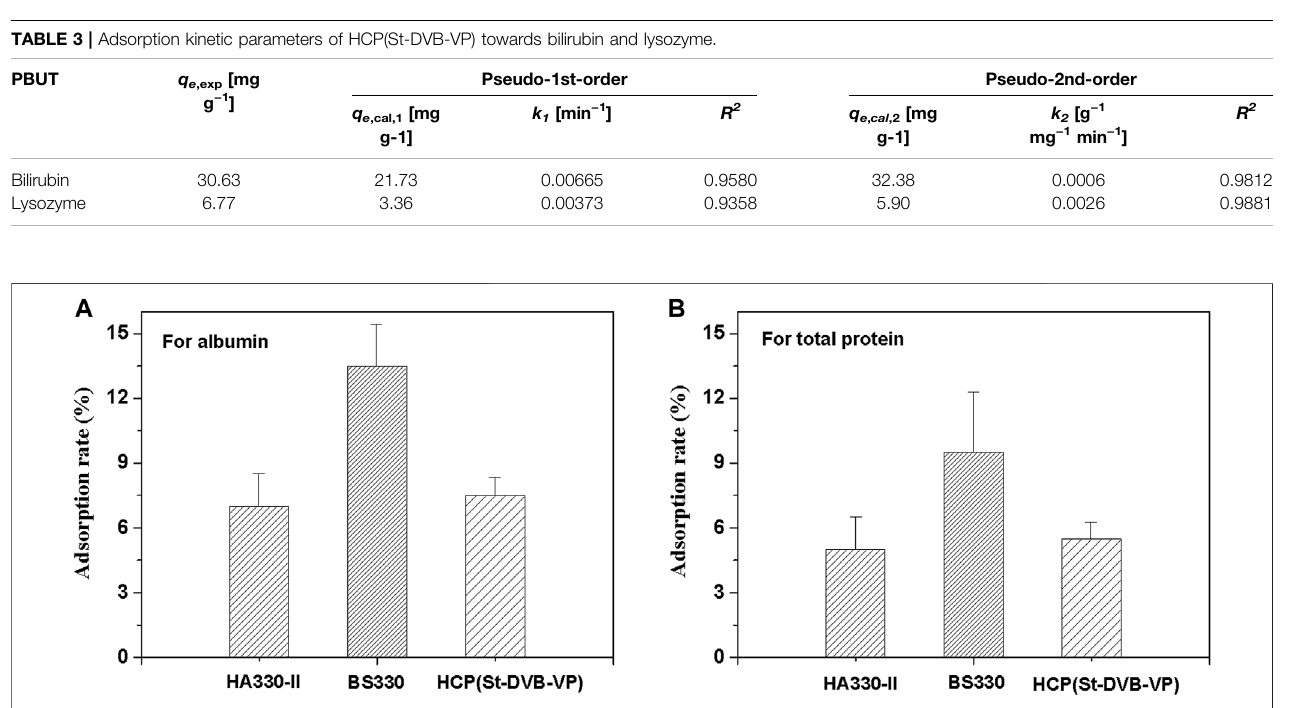
Frontiers in Chemistry |